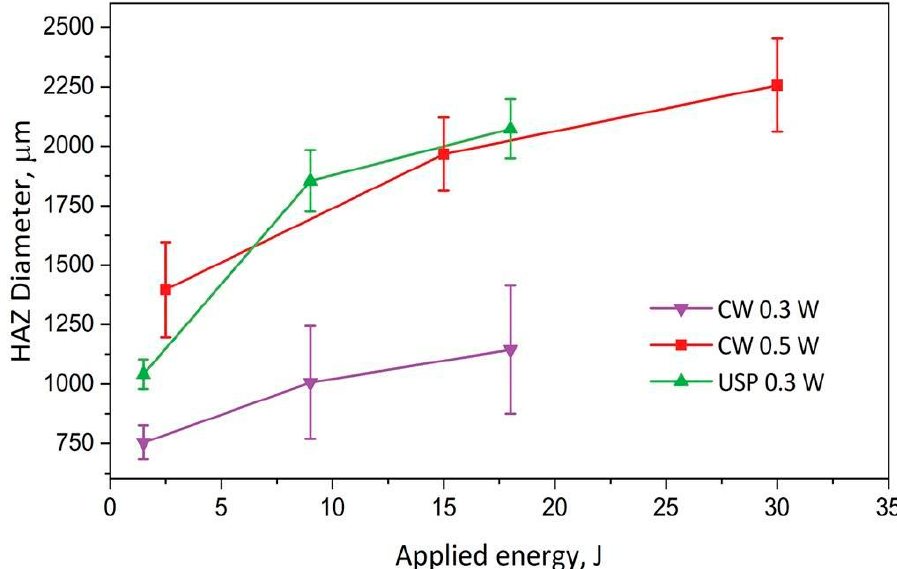
Figure 5. Dependency diagram of the heat-affected zone (HAZ) diameter on the applied energy of USP and CW laser radiation for different exposure times (5, 30 and 60 s). USP and CW laser radiation for different exposure times (5, 30 and 60